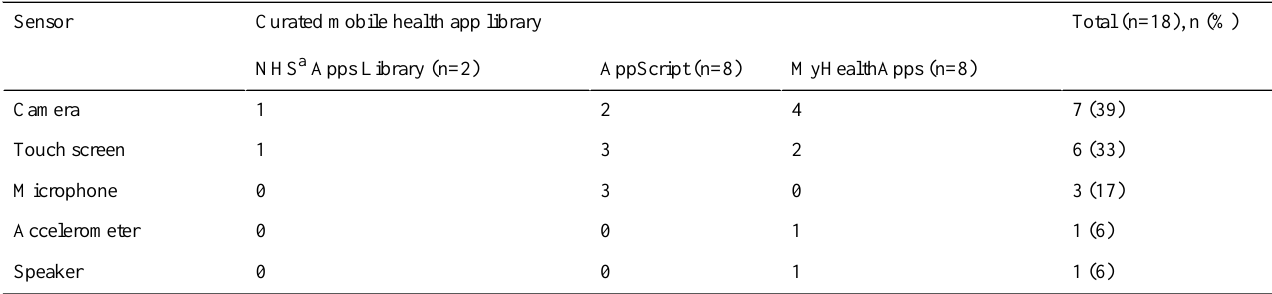
Table 4. Sensor types found in curated mobile health app libraries.